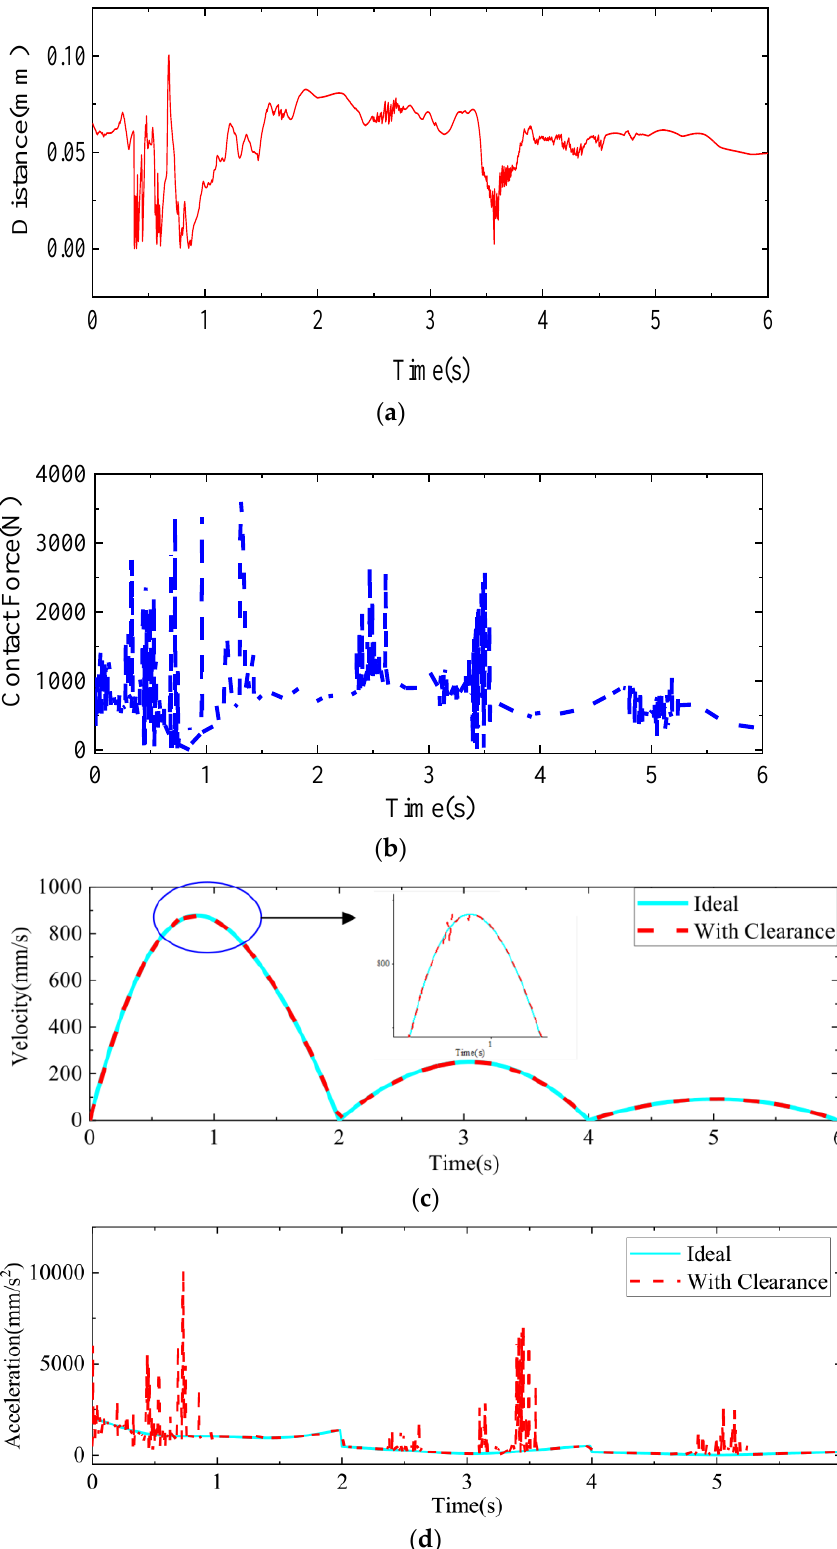
Figure 6. Curve of motion parameters of the mechanism under the influence of clearance joints: ( a )